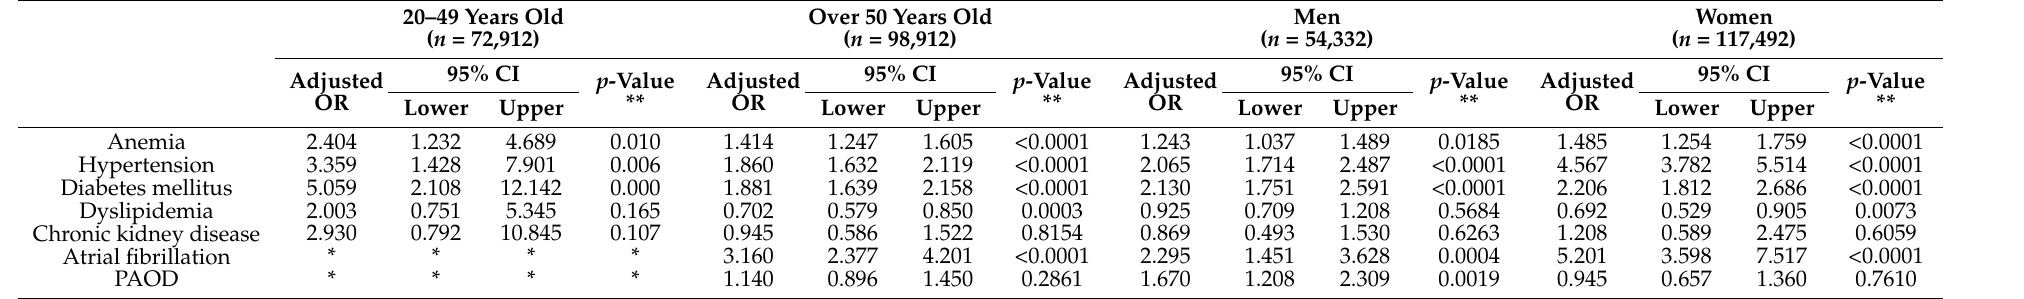
Table 3. Adjusted odds ratio of anemia for the risk of ischemic stroke within 2 years in patients: subgroup